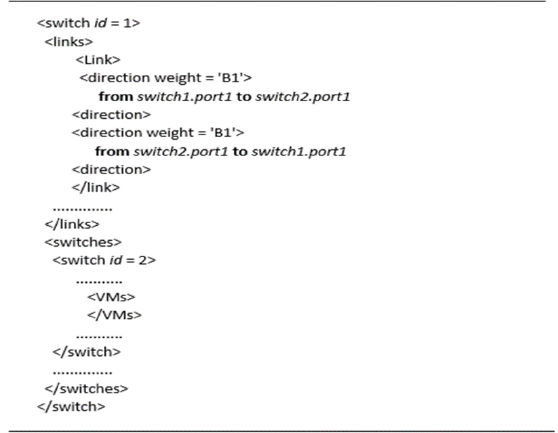
Figure 2. GANA model XML description.